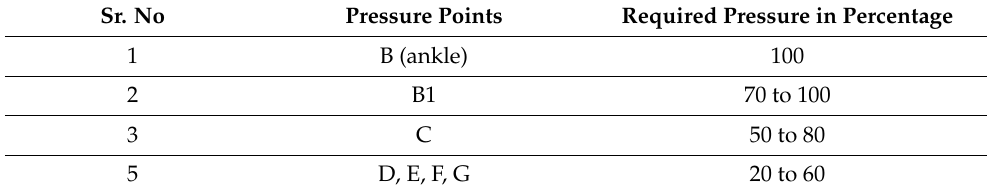
Table 4. Gradients of the studied compression stockings [18,27].